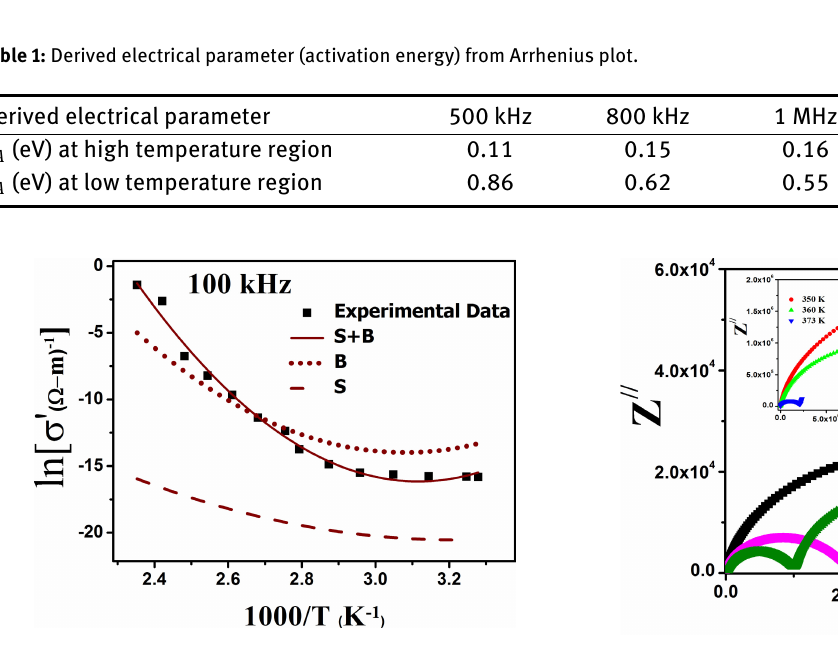
Figure 3: Plot of ln σ vs. 1000/T for the film sample at 100 kHz fre- quency.